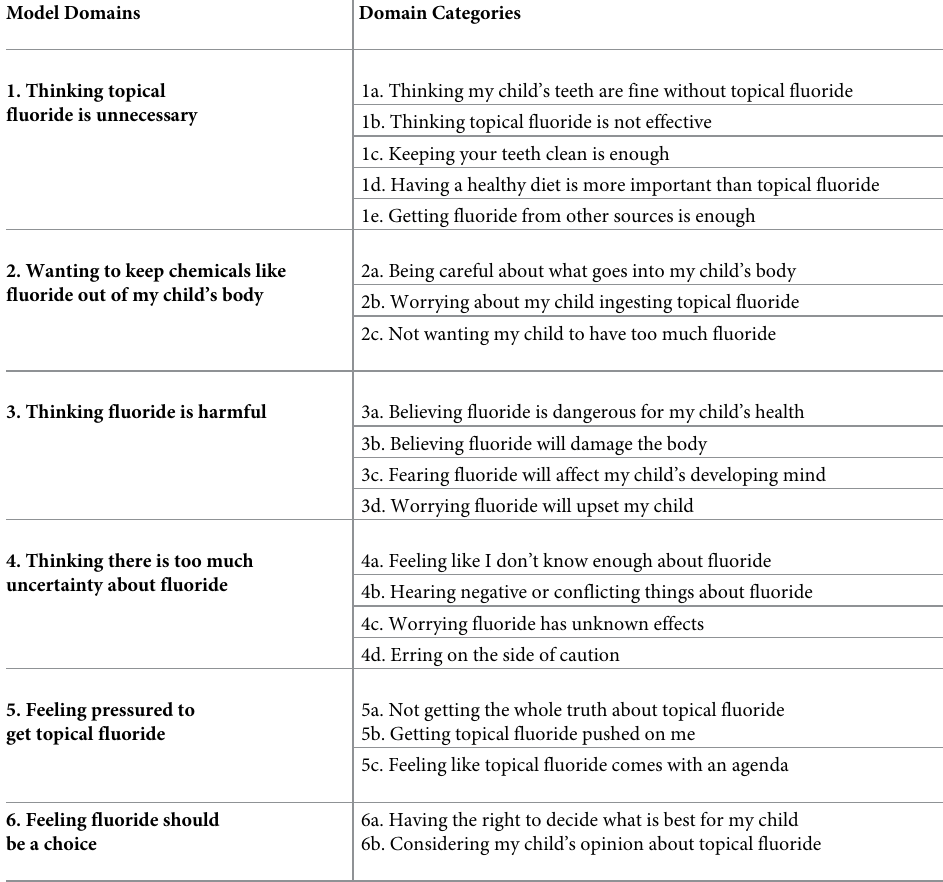
Table 2. Domains and categories for a conceptual model of caregivers’ hesitancy of topical fluoride for their children. Model